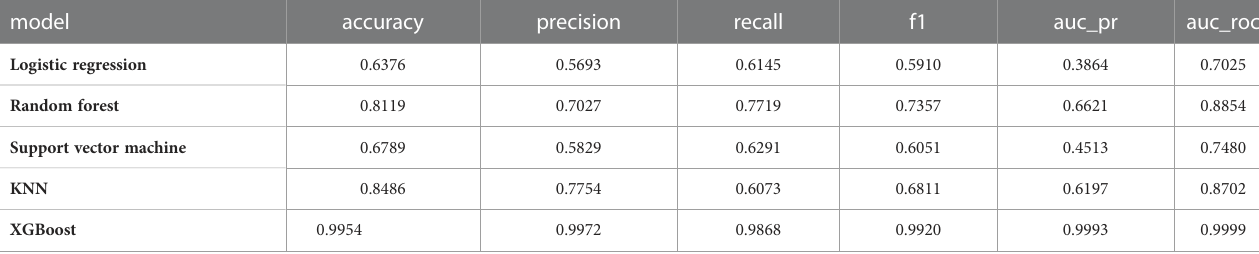
TABLE 3 Results of the training sets using fi ve machine learning algorithms. model